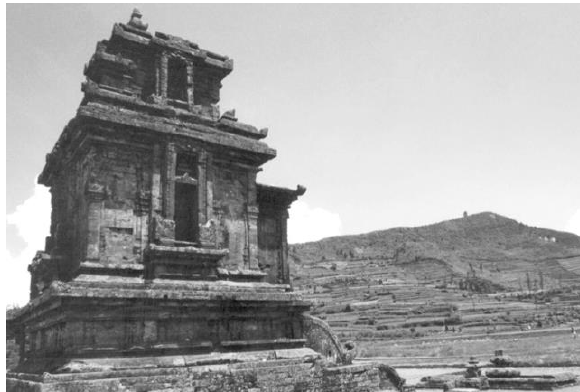
Figure 2. Borobudar, 9th century Mahayana Buddhist temple located in Central Java, offers a glimpse of ingenuous Indonesian architecture, Indonesia, a Country Study, William H.